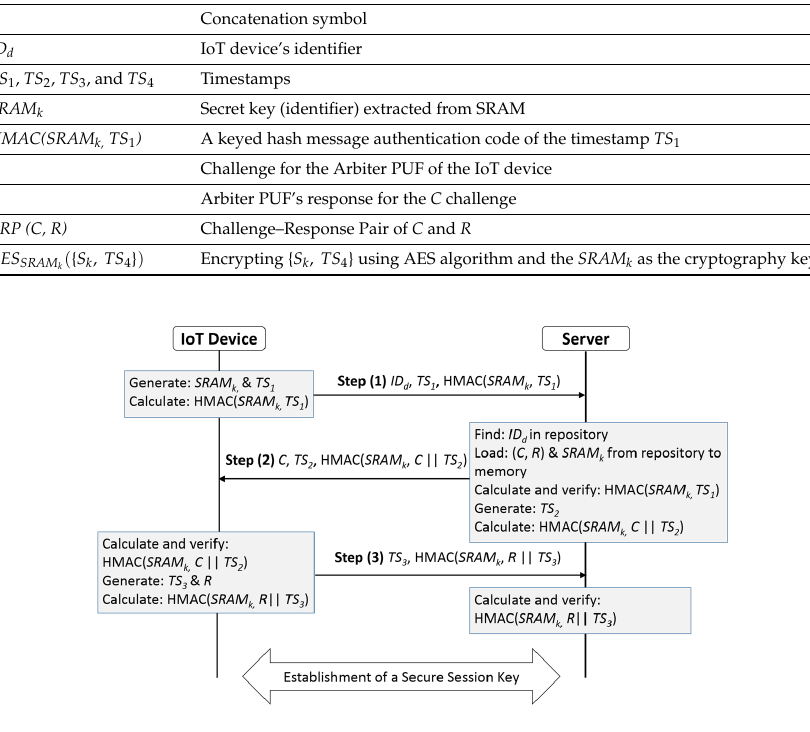
Figure 4. Proposed mutual authentication steps.